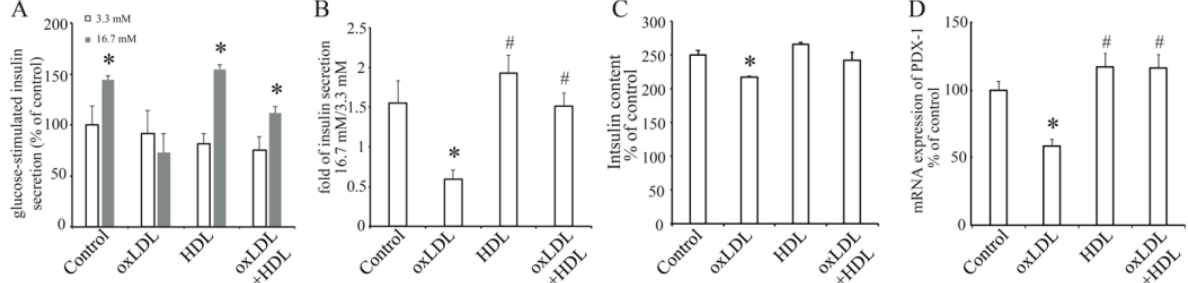
Figure 1. The effect of OxLDL on insulin secretion and synthesis in INS-1 cells. ( A ), glucose-stimulated insulin secretion (GSIS) in INS-1 cells treated with OxLDL at 50 μg /mL, HDL at 10 μg /mL or both. White bar, stimulation with glucose at 3.3 mM; gray bar, stimulation with glucose at 16.7 mM. ( B ), fold of insulin secretion from 3.3 mM glucose to16.7 mM glucose in INS-1 cells. ( C ), the total insulin content in INS-1 cells treated by OxLDL and HDL. ( D ), the effect of OxLDL and HDL on mRNA expression of PDX-1. The ratio is shown as percent of control. Data is presented as the mean ± SEM ( n = 3) of separate experiments for each group. ( A ), * p < 0.05 compared to white bar in each group. ( B – D ), * p < 0.05 compared to control; # p < 0.05 compared to OxLDL.